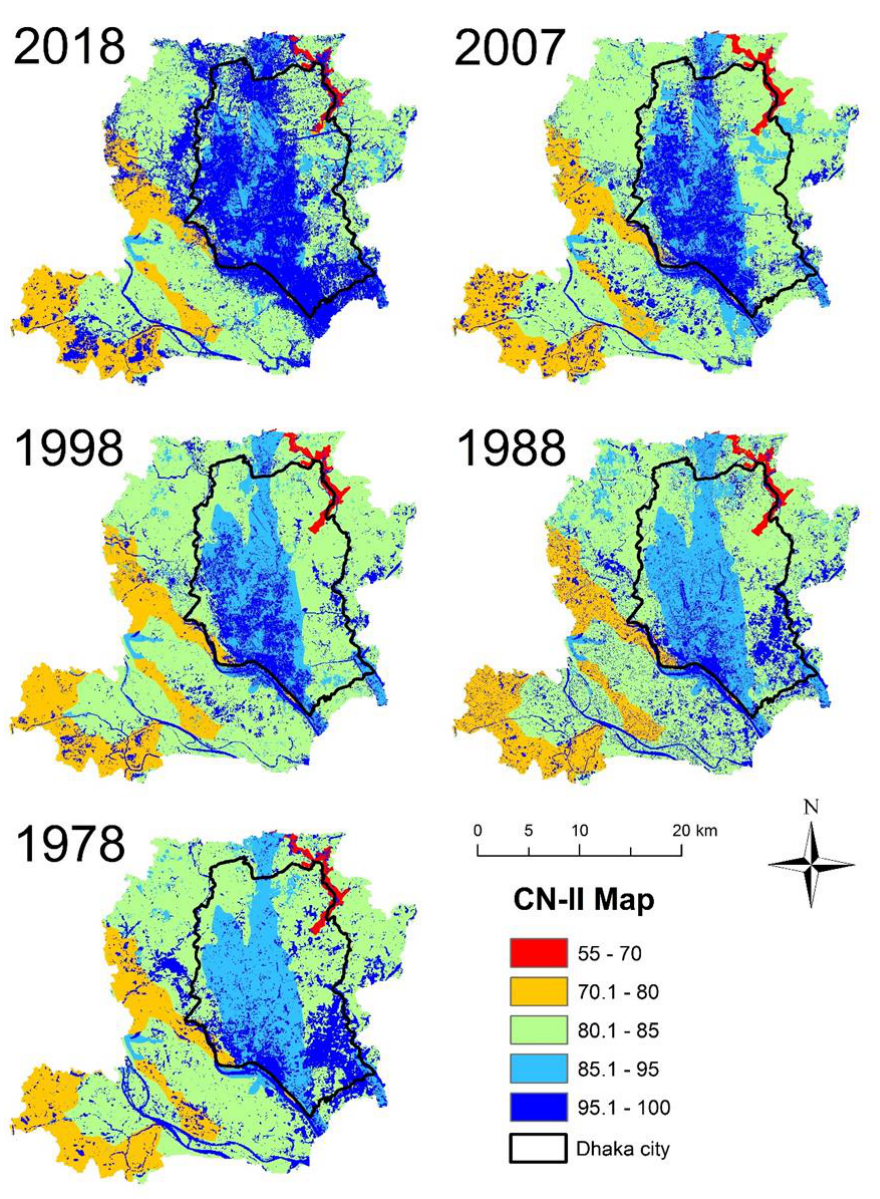
Figure 4. CN-II map.